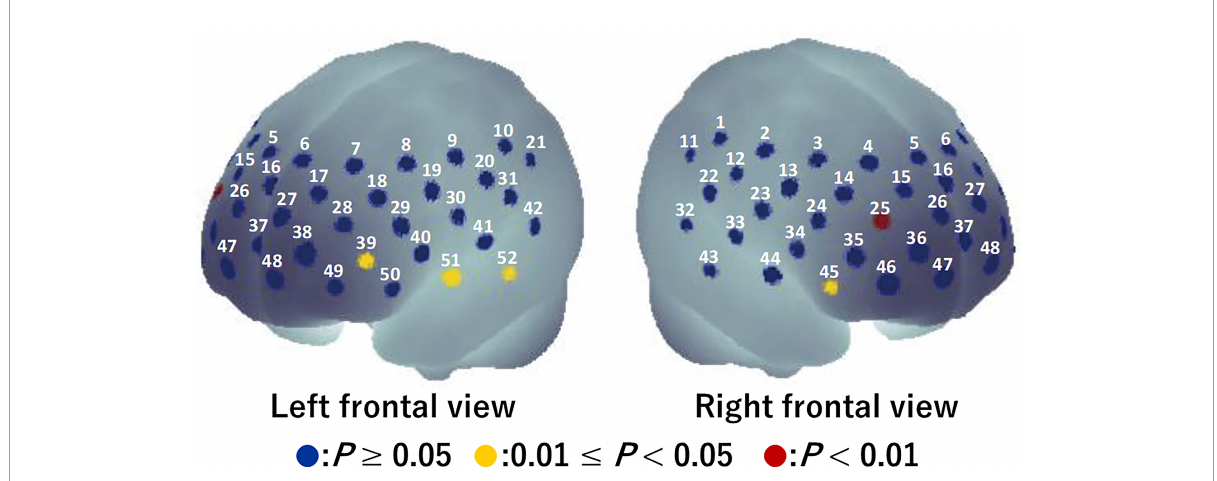
FIGURE6 Activation map during Go/NoGo blocks in the auditory task before watching a 1-h movie using a one-tailed one-sample t -test. Blue circles indicate P ≥ 0.05, yellow circles indicate 0.01 ≤ P < 0.05, and red circles indicate P <